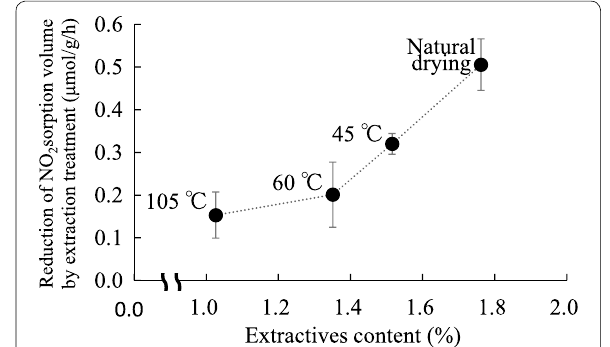
Fig. 8 The relationship between the reduction of NO 2 sorption volume by extraction treatment and the extractives content. The error bars show the standard deviation ( n =